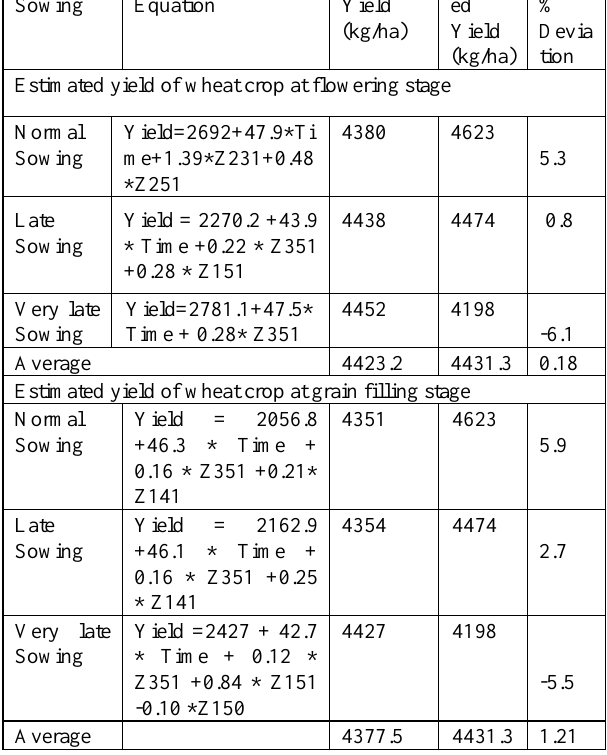
Table 4: Percentage deviation of observed yield from estimated yield of wheat crop by weather based model ( Rabi 2017-18)